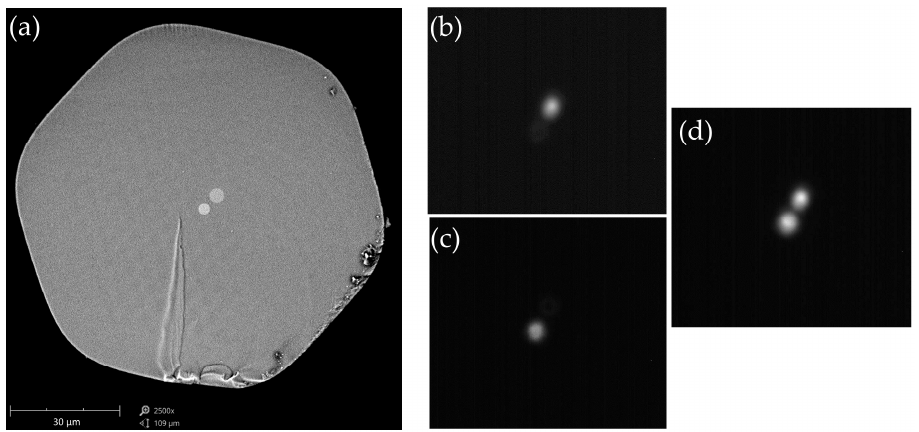
Figure 1. ( a ) Cross-section of the twin-core fiber (TCF) and pictures of mode fields where ( b ) the smaller core is excited, ( c ) the larger core is excited, and ( d ) both cores are equally excited.